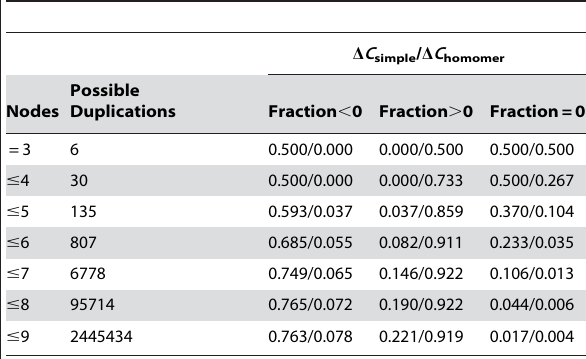
Table 2. D C as the number of nodes in the enumerated networks